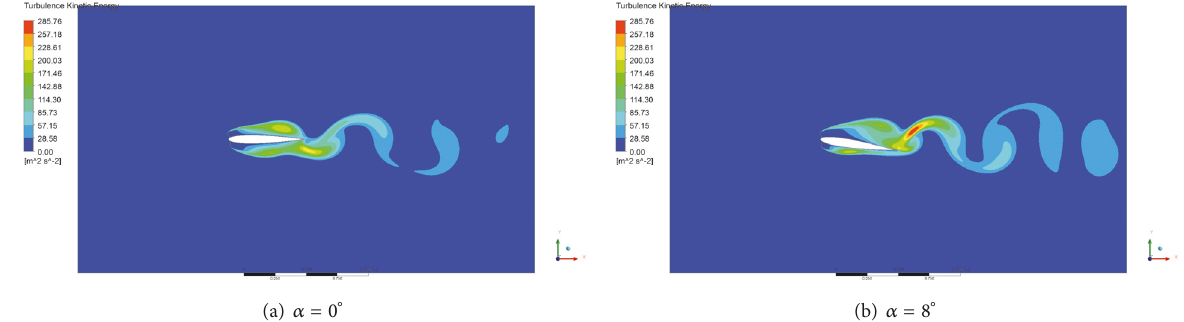
Figure 6: Turbulence kinetic energy contour in zero- and eight-degree angle of attack.